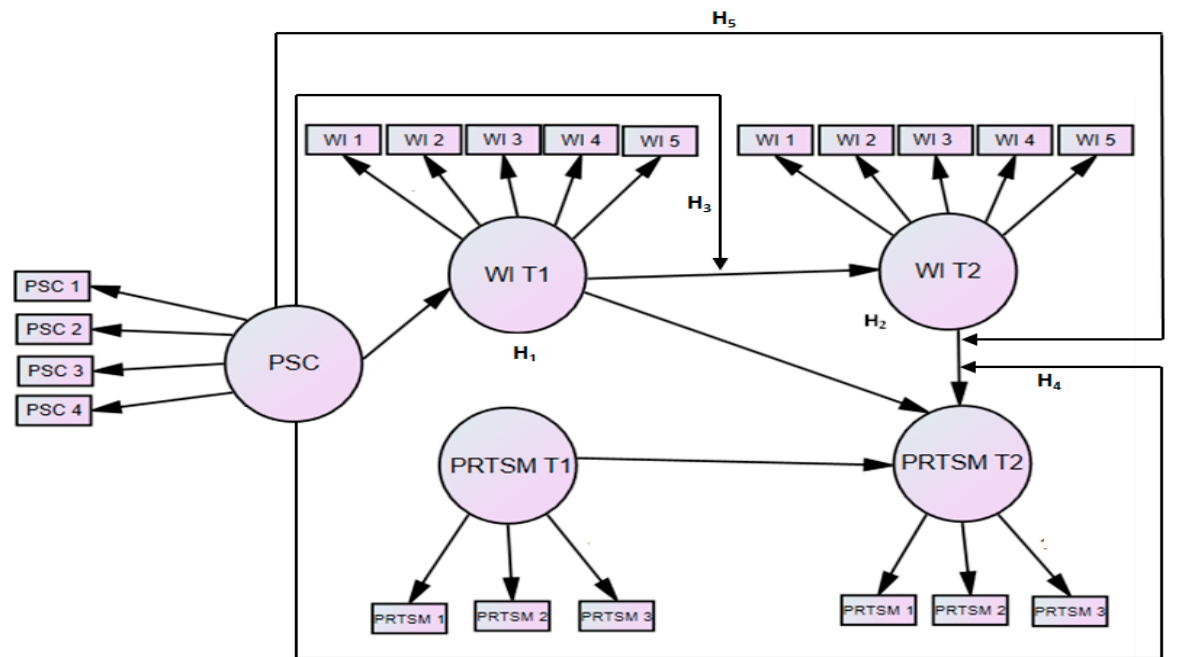
Figure 2. Hypothesized model showing number & direction of items, direction of the relationships and the hypotheses.